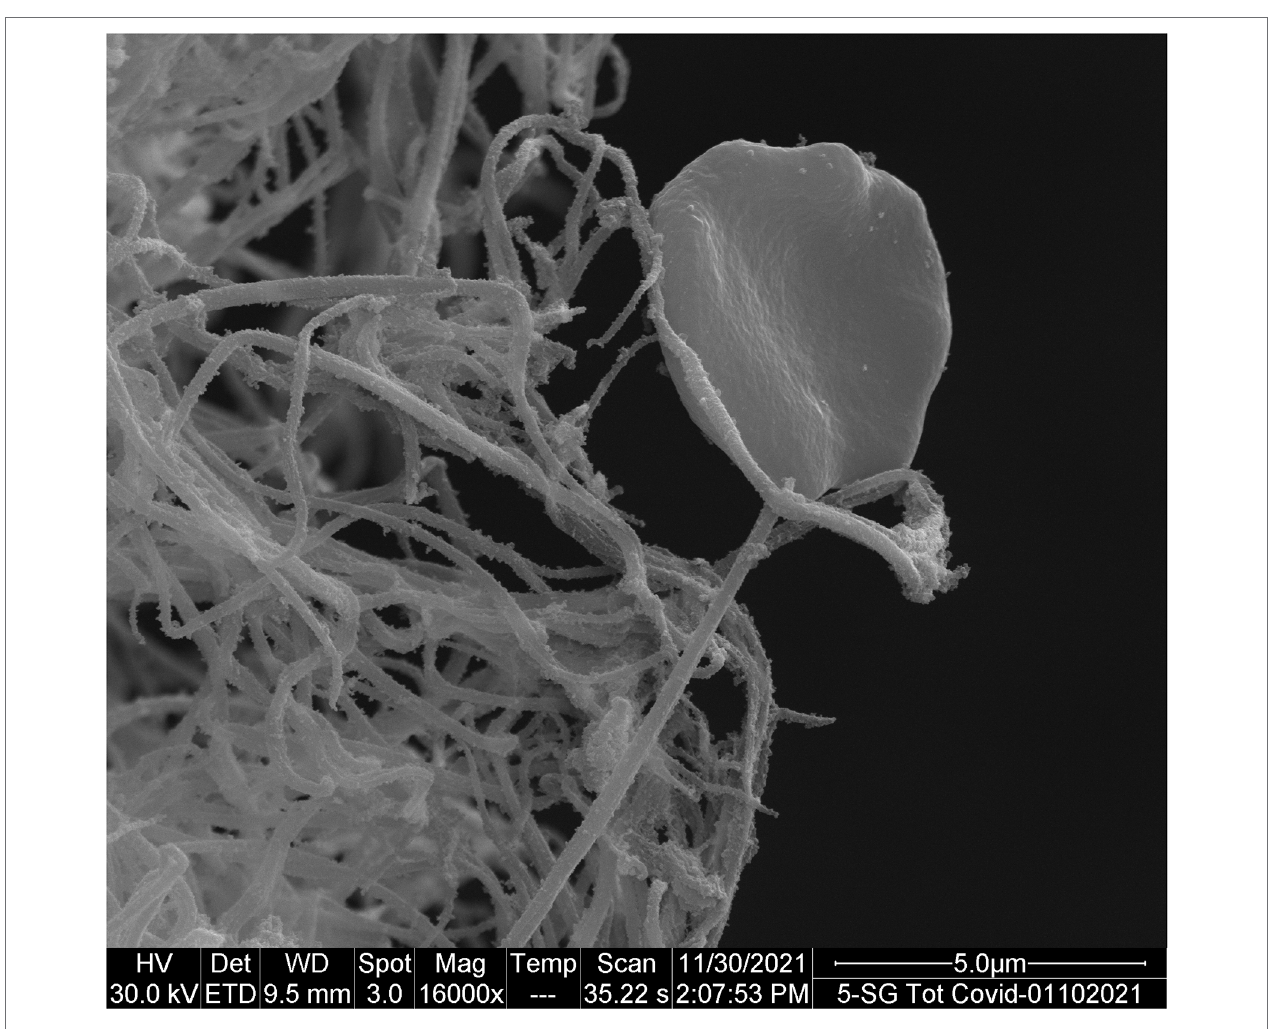
FIGURE 3 | RBC of a COVID-19 patient with a typical biconcave